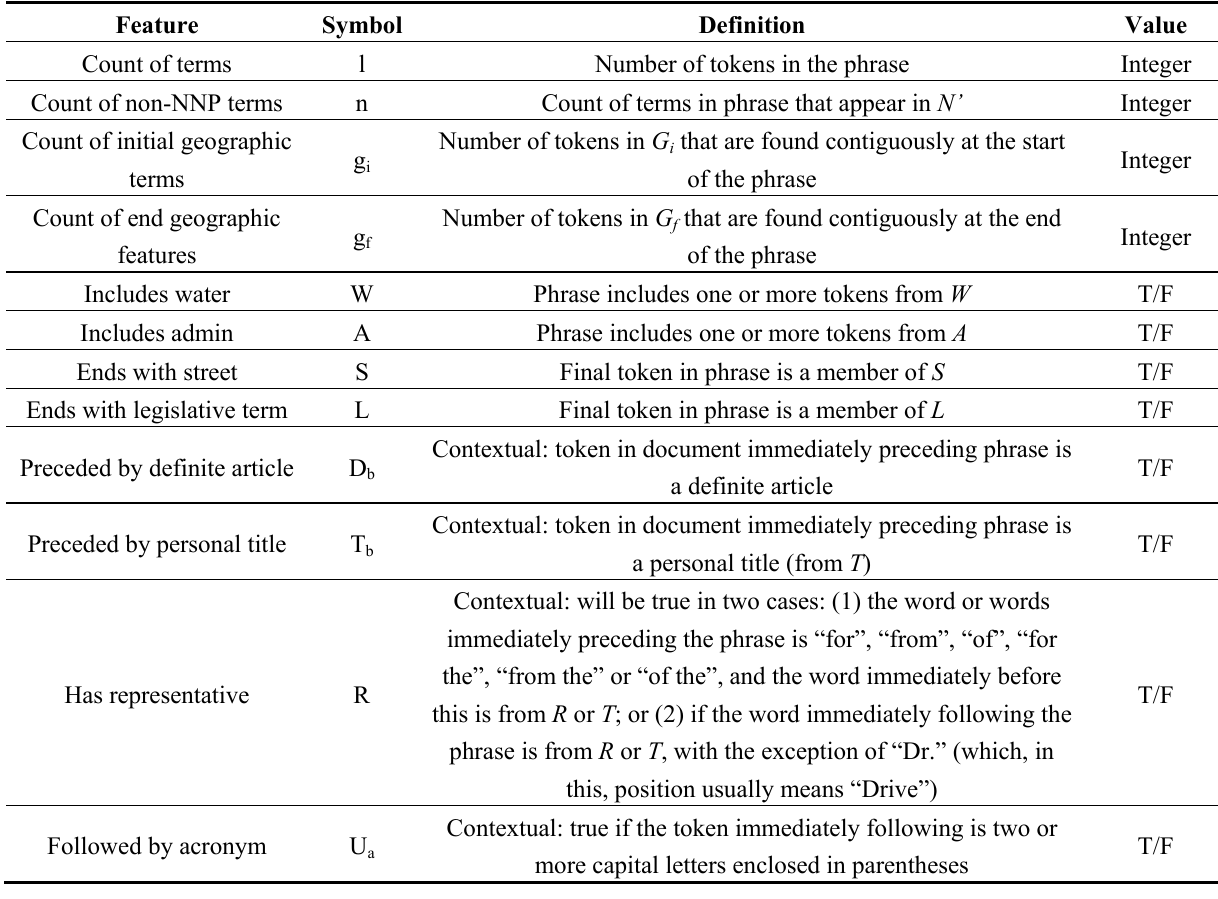
Table 2. Internal and contextual criteria used for named entity